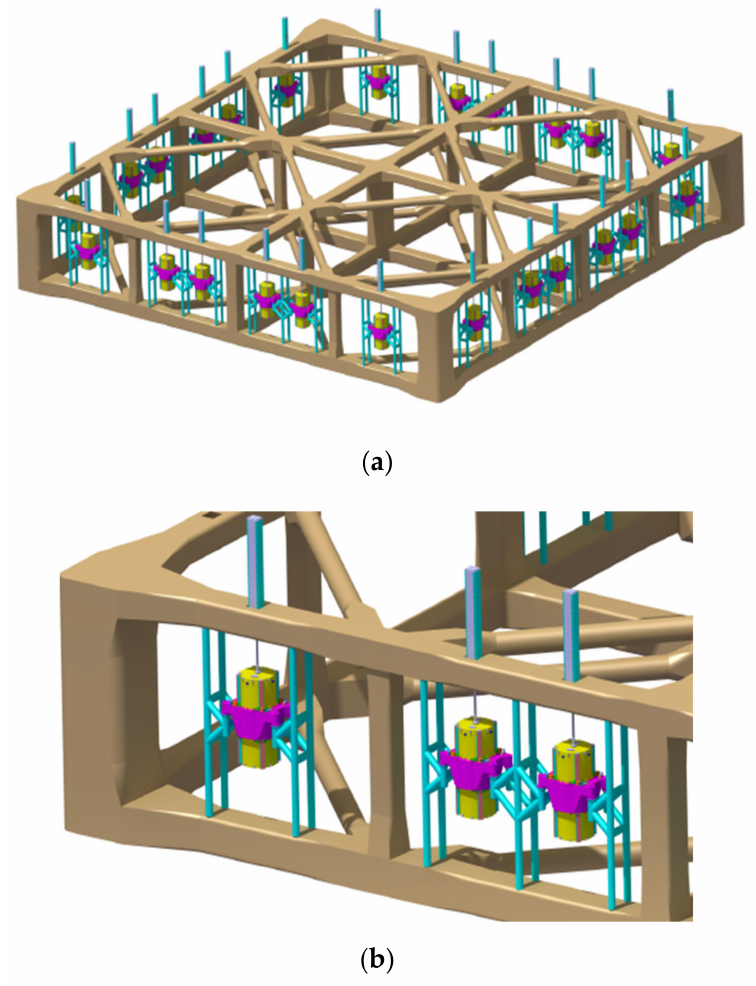
Figure 2. ( a ) Large semi-submersible; ( b ) Wave energy